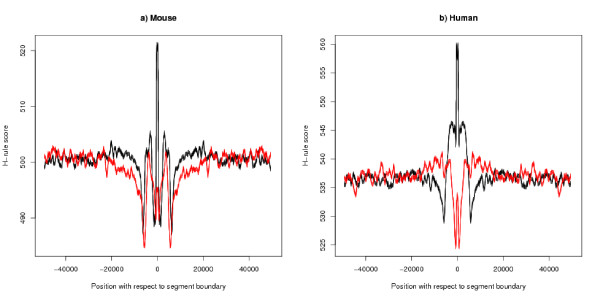
H-rule measure by position with respect to segment boundary. The black line (line with peak) gives the value of the H-rule measure with respect to the A+/T+ boundary, and the red line with respect to the T+/A+ boundary. The data from both sides of the boundary have been averaged. The thickness of both lines shows 95% confidence limits. The black line has a peak at the boundary but the red line does not. This suggests that the A+/T+ boundary is a region which binds to the nuclear proteins of the matrix, in particular, SATB1. a) Mouse: b) Human (genome assembly NCBI35). For both plots the difference between the lines at the boundary is statistically significant, two-tailed z-test: a) p < 10-50, n1 = 11750, n2 = 11753, z ~ 104: b) p < 10-50, n1 = 12375, n2 = 12369, z ~ 96.